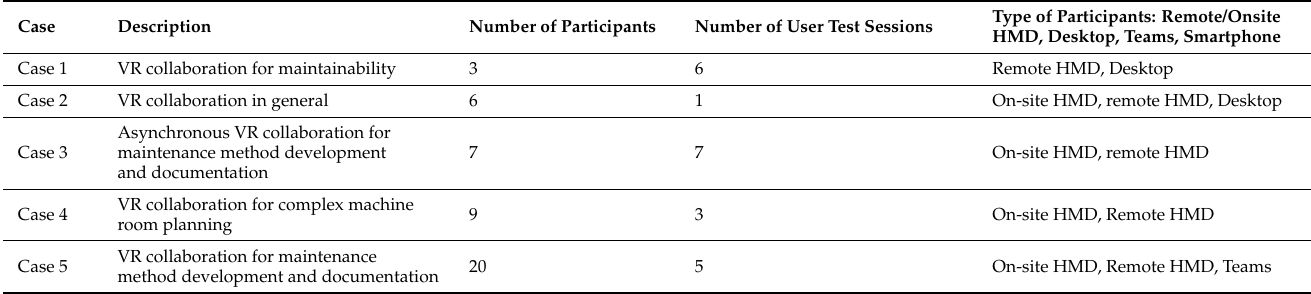
Table 1. Summary of user test cases.